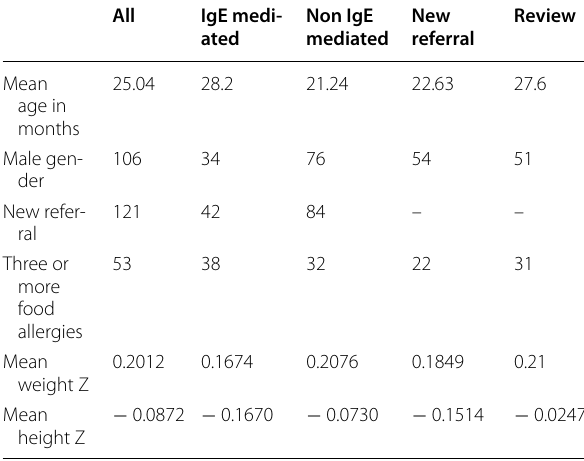
Table 1 Characteristics of children included in